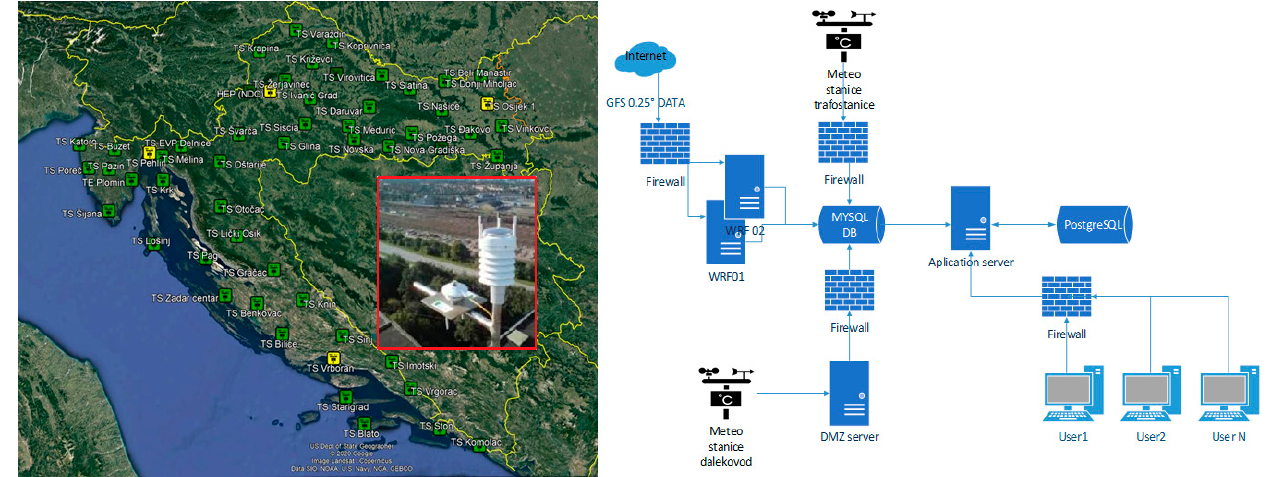
Figure 16. Meteorological stations in Croatia and the configuration of the meteorological system.